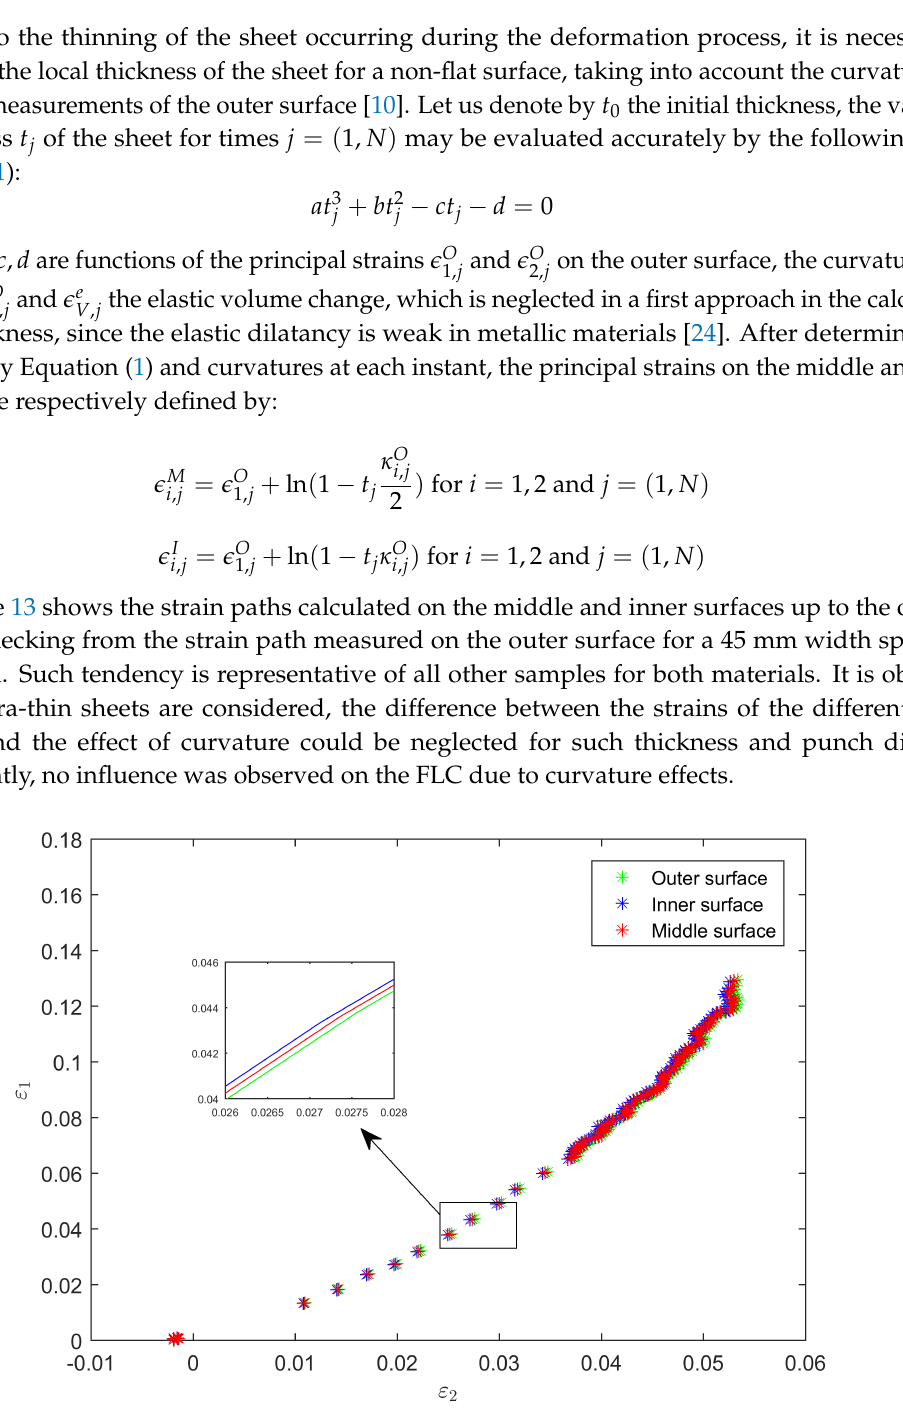
Figure 13. Strain paths on the outer, middle and inner surfaces of a 45 mm width specimen of pure